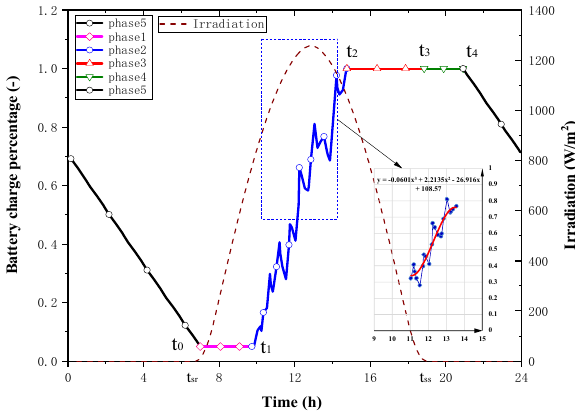
t 4 Figure 9. Optimal yaw angle profile with minimal battery mass. 0